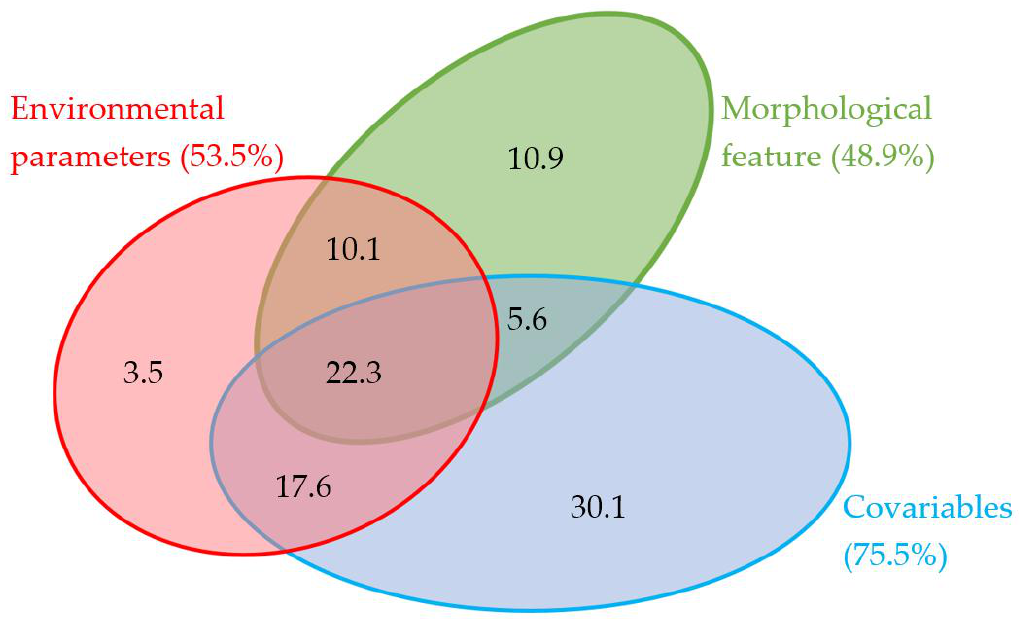
Figure 7. Division of the explained variation in the species abundance over the environmental parameters (slope, sedimentation-erosion, bed level, aspect, D50, organic matter, and mud percentage), the covariables (alongshore variation, temporal variation, and average bed level) and the morphological